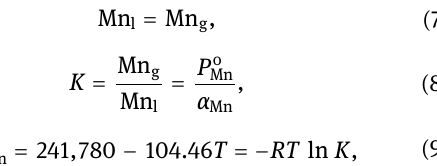
Figure 4: Relationship between ln ( K Mn ) and 1/ T .